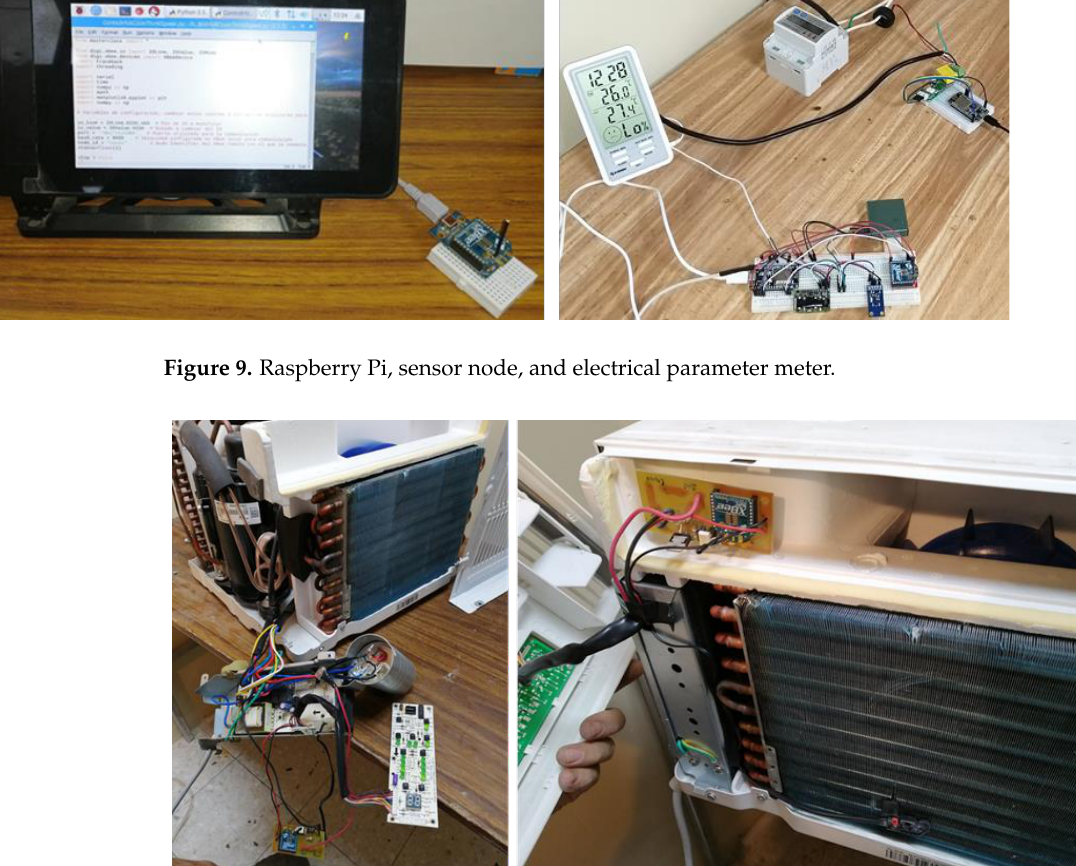
Figure 10. Compressor actuator installed in HVAC equipment.